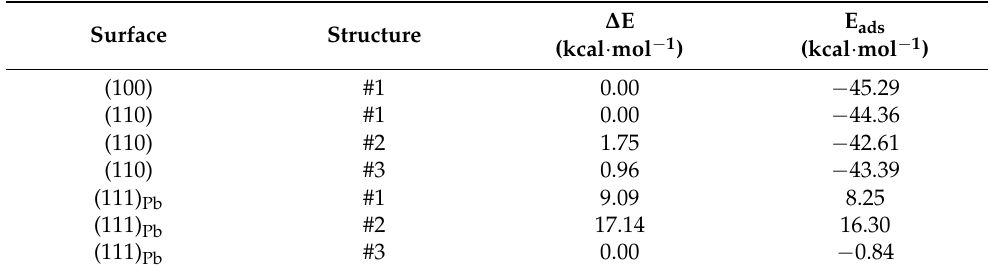
Table 2. Relative energy, ∆ E, to the most stable surface. In addition, ligand–surface adsorption energy, E ads . Surface